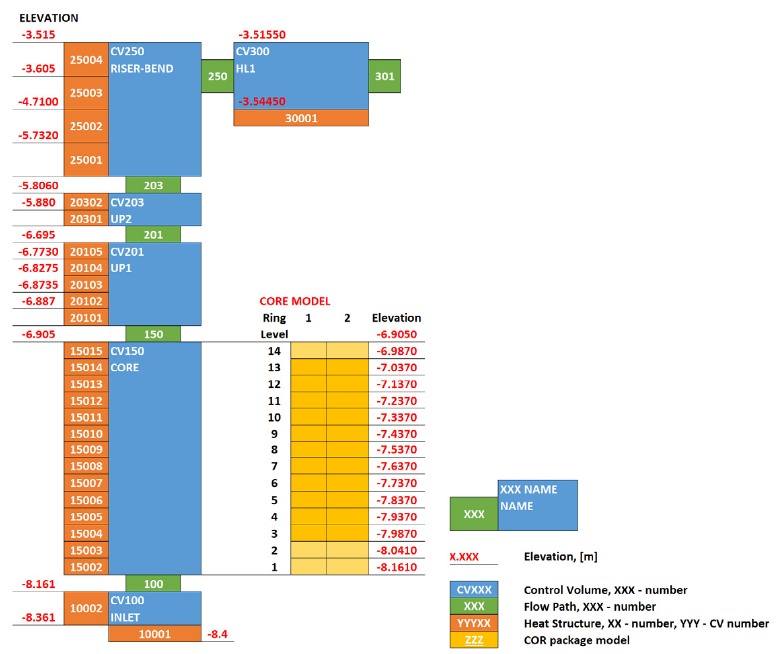
Figure 1. The MELCOR nodalization of the bundle section, including CVH, HS, FL, and COR models. All dimensions in meters. Based on [29].